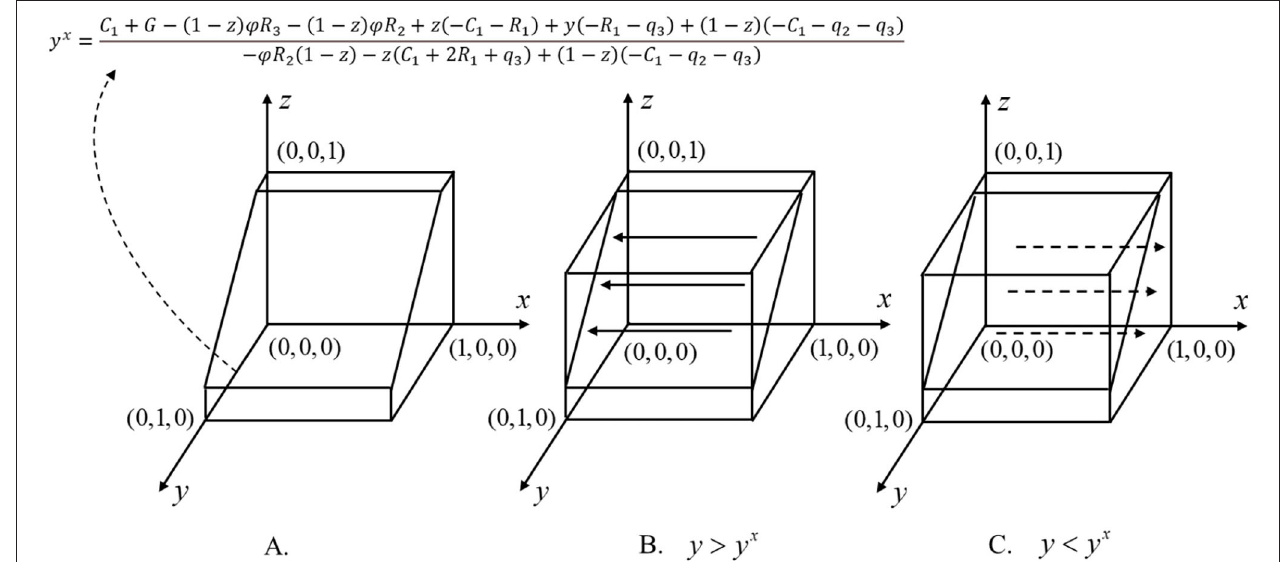
FIGURE 2 | Dynamic evolution phase diagrams of MAO’s